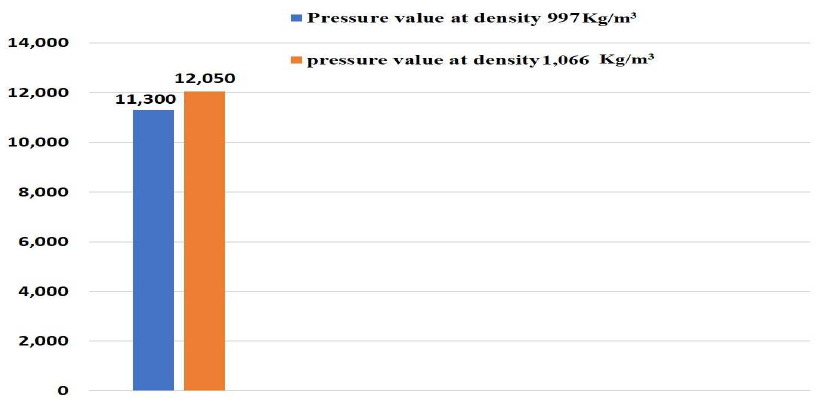
Figure 5. Sensitivity analysis on pressure parameters for two different values of densities.